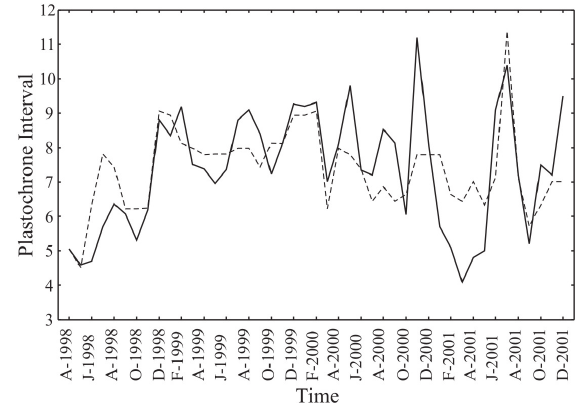
Fig . 2. – the continuous line represents plastochrone interval esti- Fig . 3. – the continuous line represents plastochrone determinations mations taken biweekly over a 45-month observation period. the through time. the dashed line was produce by the fitting of Equation dashed line represents a fitting of Equation (3) to the observed plas- (3) to these plastochrone interval values. in this case, θ ( t ) stands for tochrone interval values. in this case, θ ( t ) represents in situ surface oni values. the best fit was obtained for a polynomial of order 25 temperature anomalies and produced a determination coefficient with a determination coefficient of R 2 =0.70. oni values are based of R 2 =0.73. the best fit corresponded to the case n =25 . For P ( t ) on three-month running-mean SSt departures from average (Smith standing for observed plastochrone interval values the fitted model and reynolds, 2003). For P ( t ) standing for observed plastochrone is given by: interval values the fitted model is given by: P ( t ) = 6.55 – 5.7 θ ( t ) + 6.31 θ ( t ) 2 + 255.5 θ ( t ) 4 – 3110.3 θ ( t ) 6 – 412 θ ( t ) 7 P ( t ) = 5.7 + 0.67 θ ( t ) + 105.2 θ ( t ) 2 + 356.3 θ ( t ) 3 – 376.3 θ ( t ) 4 + 6174.6 θ ( t ) 8 + 801 θ ( t ) 9 – 9027.4 θ ( t ) 12 – 5506 θ ( t ) 13 – 4879 θ ( t ) 20 + – 2532.6 θ ( t ) 5 – 1839.6 θ ( t ) 6 + 1328.9 θ ( t ) 7 – 62.3 θ ( t ) 8 – 1029.9 θ ( t ) 9 + 1376.7 θ ( t ) 10 – 345.8 θ ( t ) 11 – 380.8 θ ( t ) i 12 + 1316.7 θ ( t ) 13 – 779.5 θ ( t ) 14 + 398.2 θ ( t ) 15 + 954.7 θ ( t ) i 16 – 859 θ ( t ) 17 + 968.8 θ ( t ) i 18 + 658.6 θ ( t ) 19